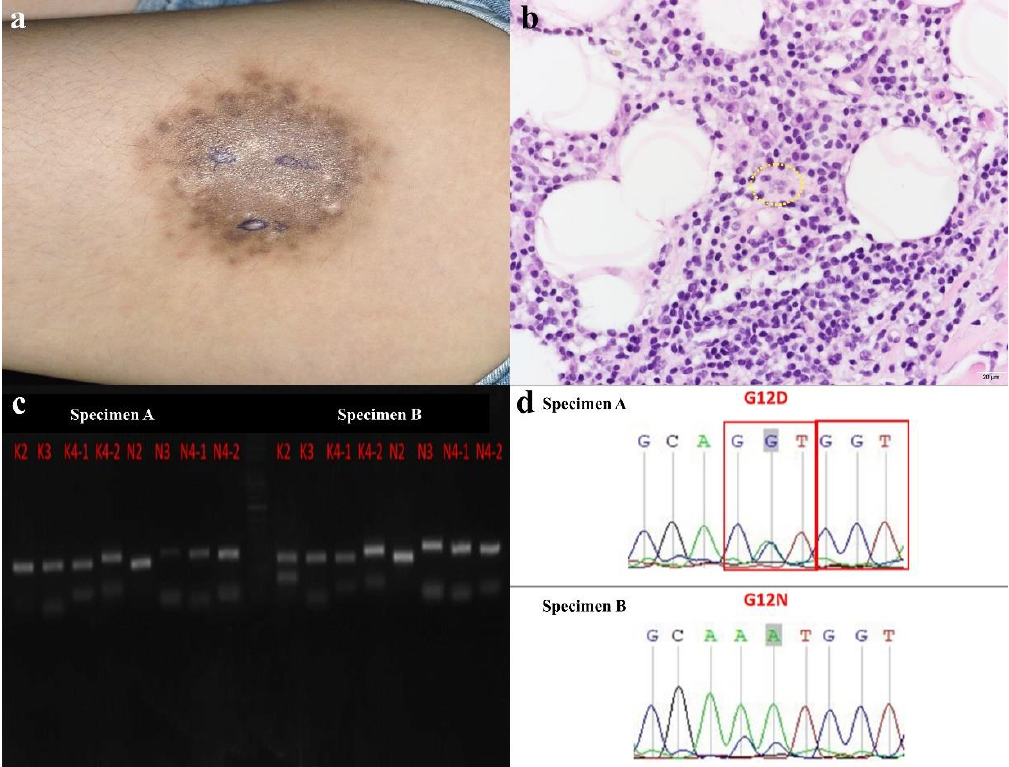
Figure 2. Clinicopathologic features and molecular analysis of the case 6. ( a ) The patient was a 17-year-old girl who presented with one 8 × 8 cm tender hard brownish plaque with some whitish papules and nodules on her left thigh for 3 years. We took two different specimens, specimen A from black parts and specimen B from white parts, for further evaluation. ( b ) In the skin biopsy, RD cells with emperipolesis were found in a prominent lymphoplasmacytic background (yellow circle, 400×). Scale bar = 20 μM. ( c ) In both specimens A and B, the agarose gel electrophoresis of PCR products for screening KRAS and NRAS mutation were present. ( d ) Further sequencing revealed NRAS G12D mutation in specimen A, and NRAS G12N mutation in specimen B.